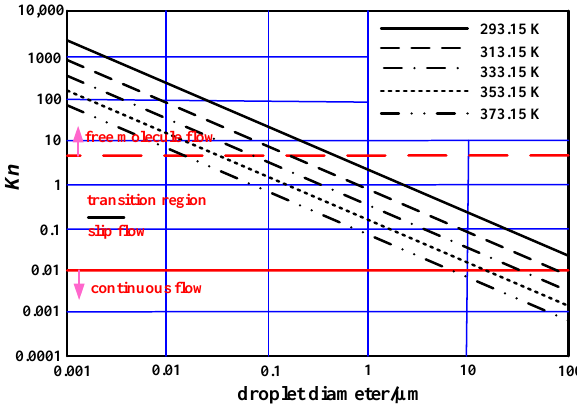
Figure 2. Relationship between the Kn and water droplet diameter.